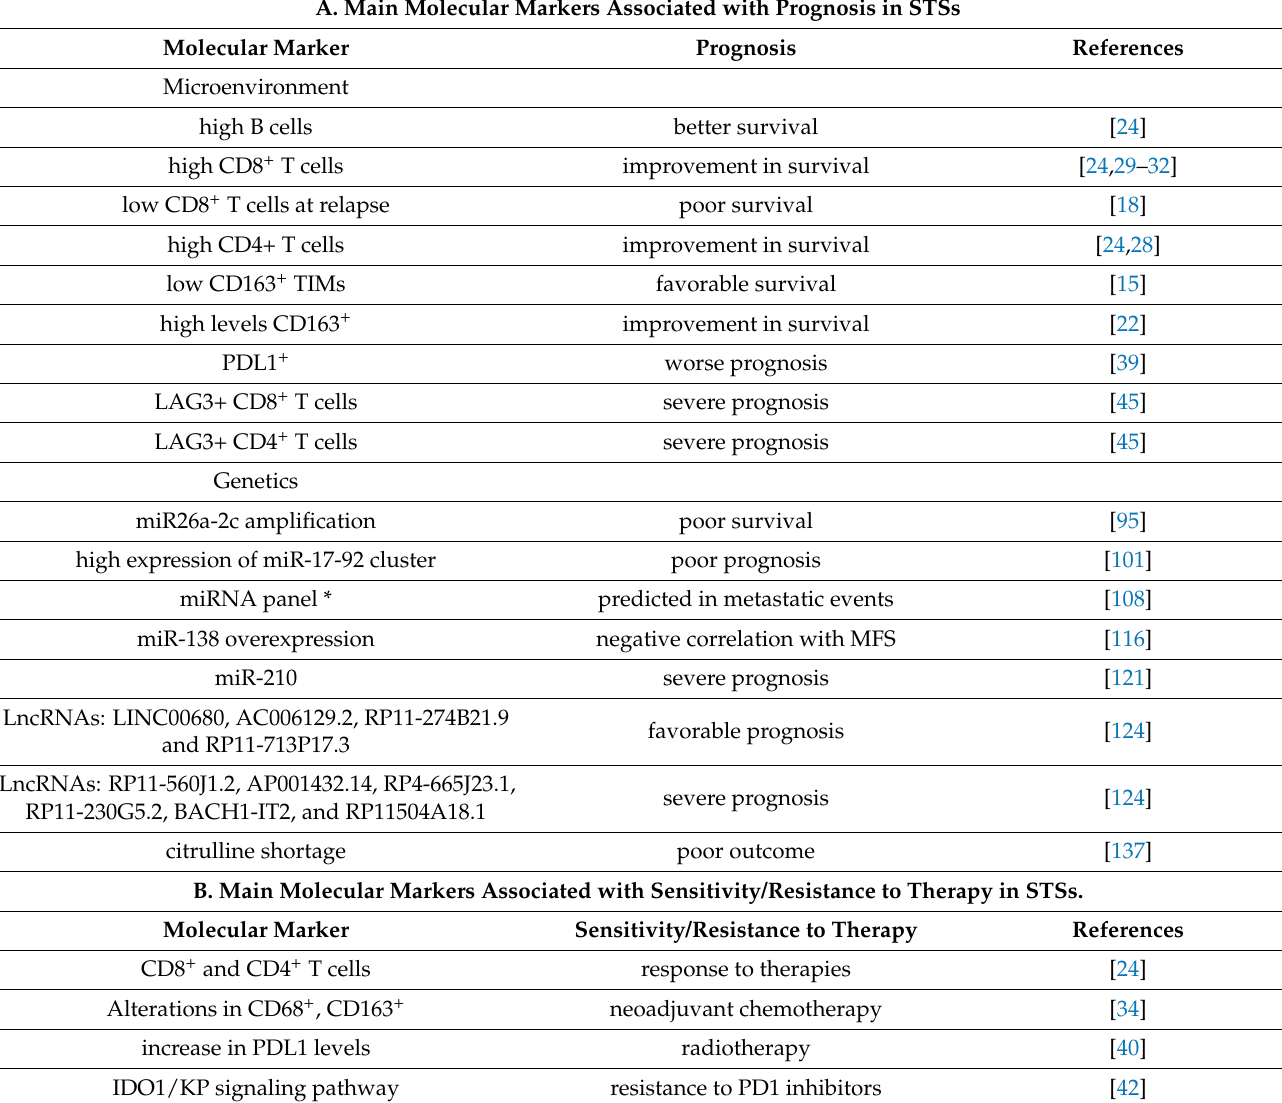
Table 1. ( A ). Main molecular markers associated with prognosis in STSs, ( B ). Main molecular markers associated with sensitivity/resistance to therapy in